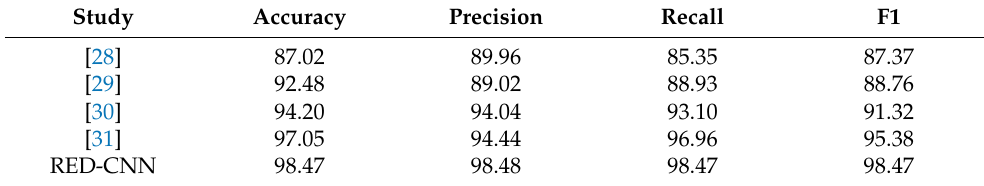
Table 7. Comparison of RED-CNN with other studies based on different datasets.